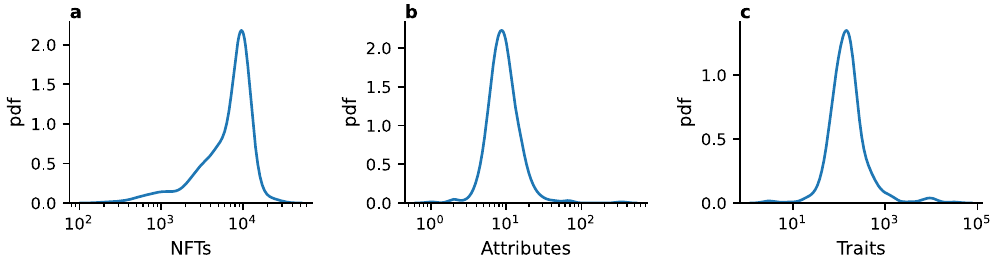
Figure 2. Characteristics of collections. The probability distribution of ( a ) the total number of NFTs within the collection; ( b ) the total number of attributes in the collection; ( c ) the total number of traits in the